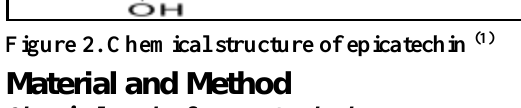
Figure 2. Chemical structure of epicatechin (1) Material and Method